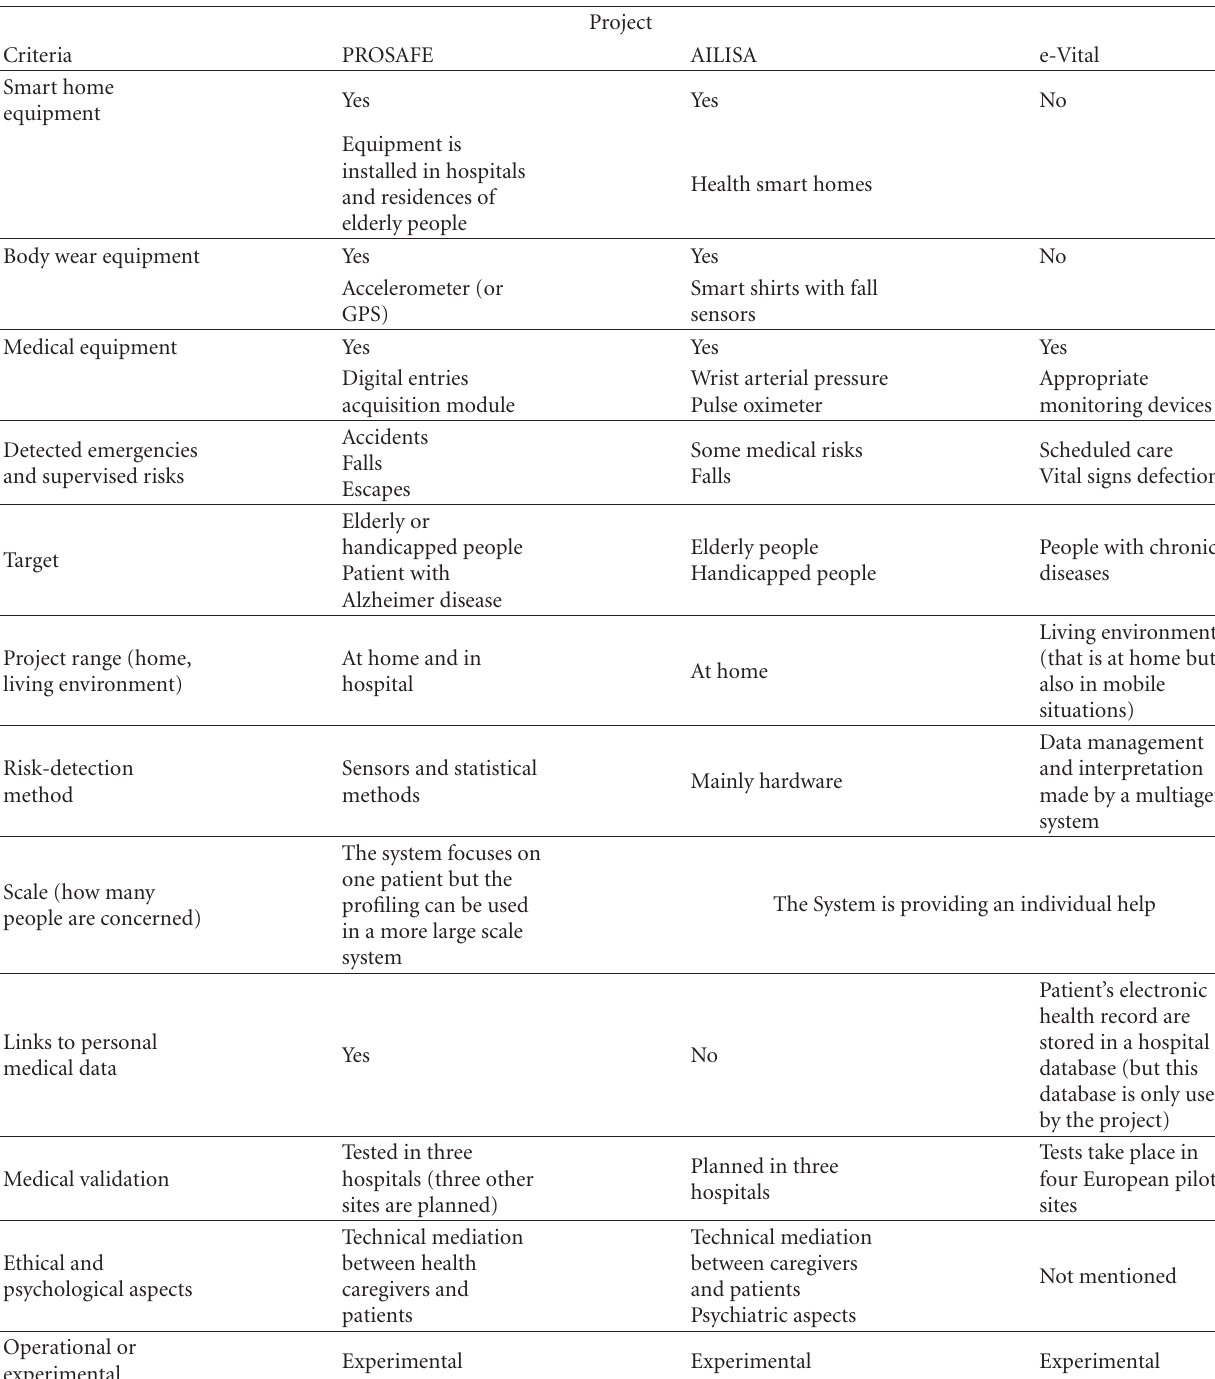
Table 1: Overview of the three